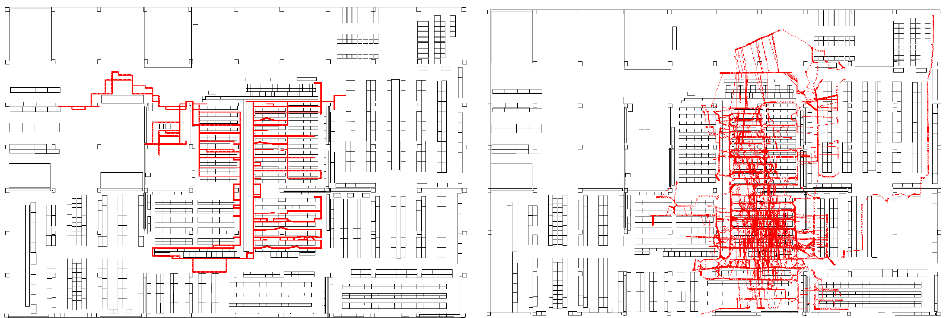
Figure 14. Examples of trajectories in the PDR track submitted by high achievers.